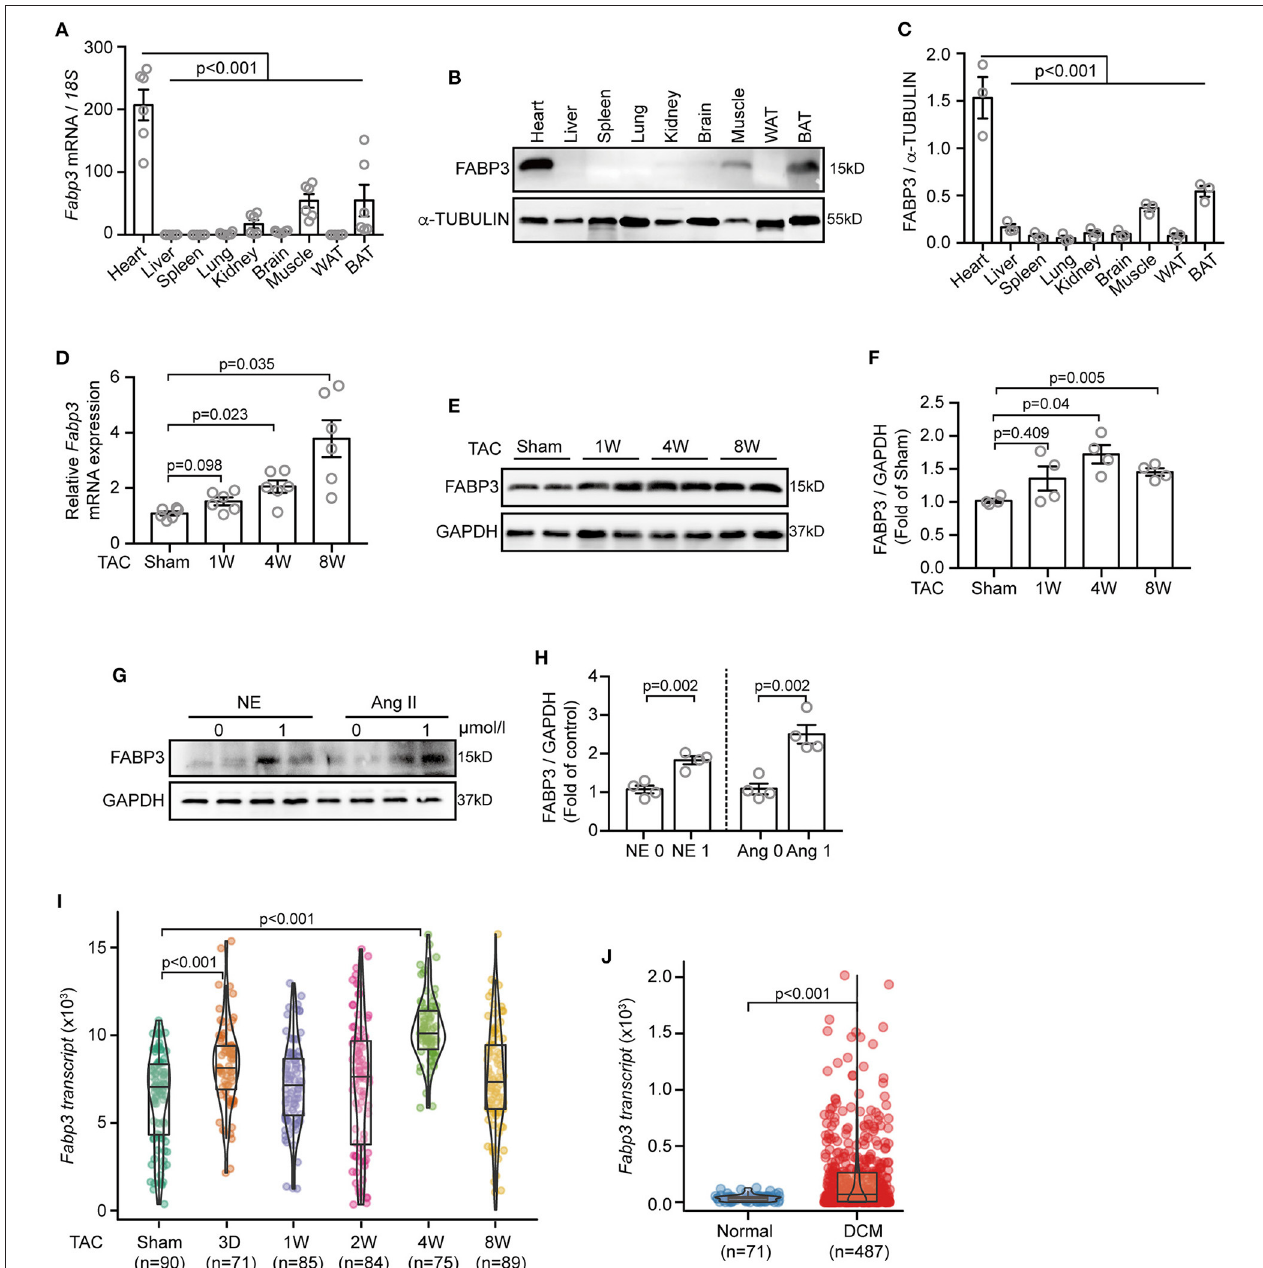
FIGURE 1 | TAC or Ang II upregulates the FABP3 expression in vivo and in vitro . (A–C) Mouse tissues were extracted for qPCR and western blot analyses to determine Fabp3 levels. (A) qPCR analysis of Fabp3 mRNA in the indicated organs; 18s was used as the control. (B) The FABP3 protein level in the corresponding tissue was determined using western blotting. (C) Quantification of FABP3 expression in (B) . ( D) The mRNA level of Fabp3 after TAC operation, as determined using qPCR. (E) Representative western blot images showing the FABP3 expression. (F) Quantification results for (E) . (G) NRVMs treated with NE or Ang II were subjected to western blotting assay to determine the FABP3 protein expression. (H) Quantification results of (G) . (I,J) Single cell RNA sequencing of TAC-operated murine hearts or heart samples from DCM and normal patients were recalculated for the transcriptional expression of Fabp3 (GEO accession code: GSE95143 ). [ A , n = 6; C , n = 3; (A,C) Dunnett’s post-hoc test; D , n = 6; F , n = 4; (D,F) Games–Howell post-hoc test; H , n = 4; (H,J) Student’s t -test; (I) Dunnett’s post-hoc